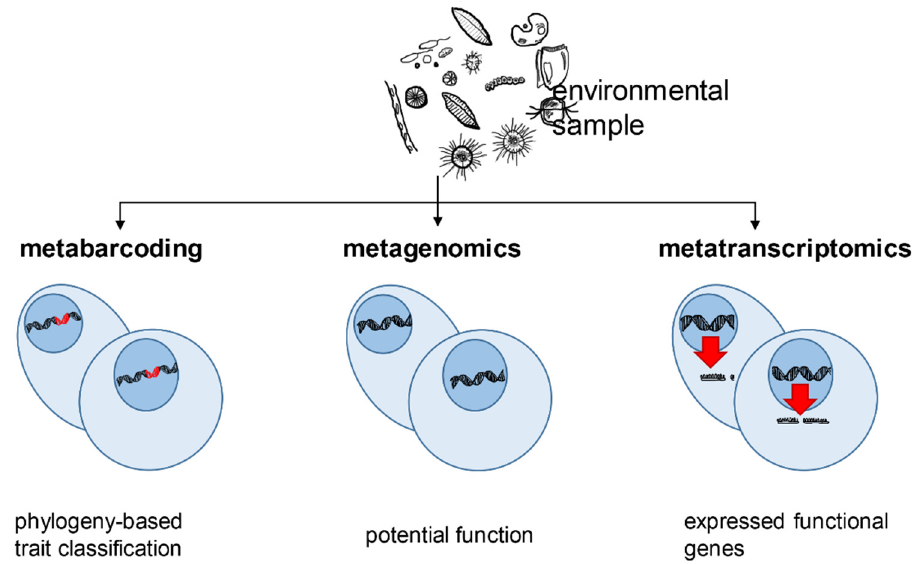
Figure 1. Schematic graph of DNA and RNA of an environmental sample accessed by metabarcoding, metagenomics, and metatranscriptomic approaches and their functional information.